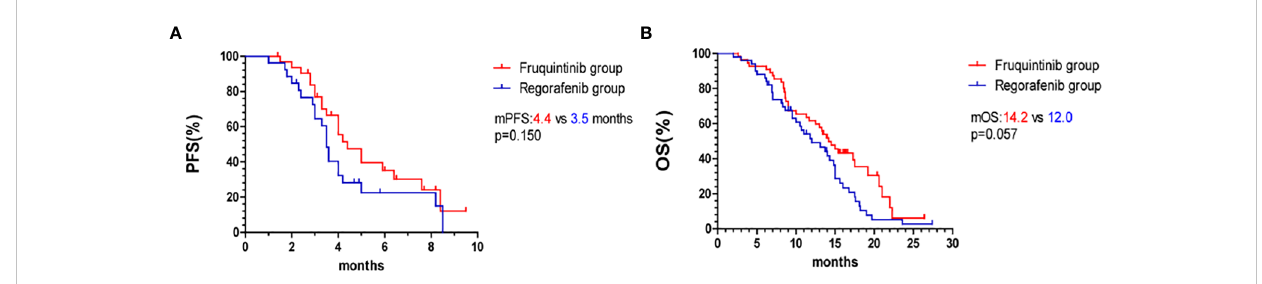
FIGURE 2 Kaplan – Meier curves. (A) PFS in the fruquintinib group and regorafenib group. (B) OS in the fruquintinib group and regorafenib group. mPFS, median progression-free survival. mOS, overall